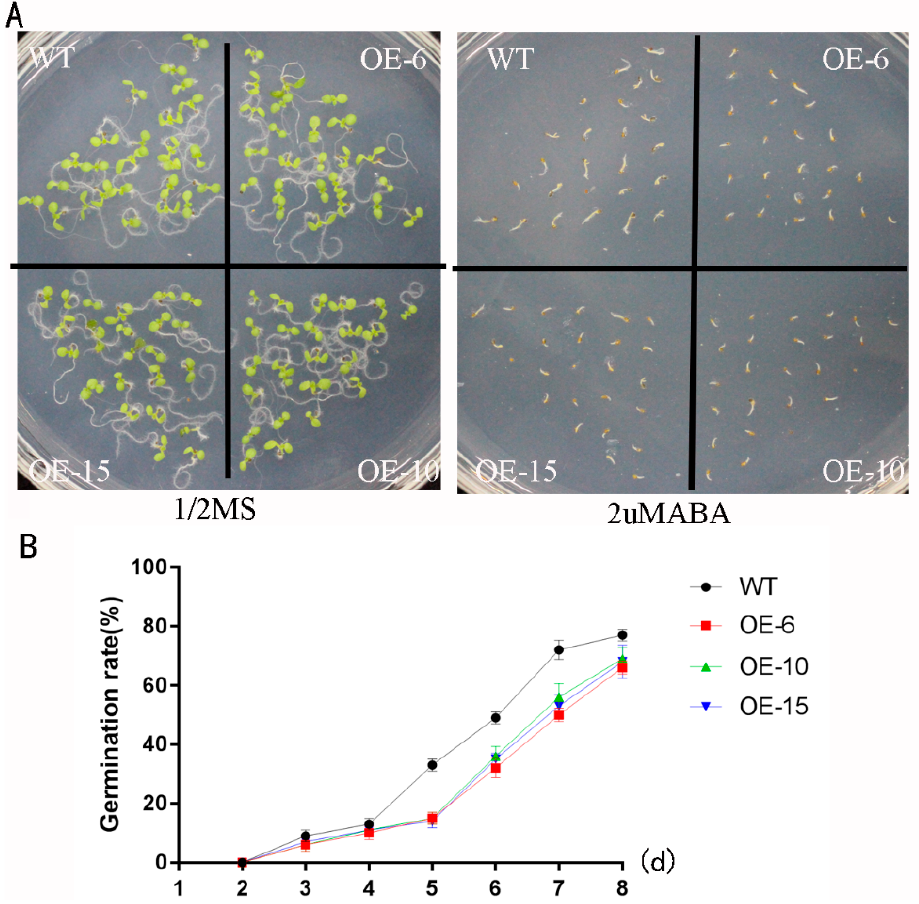
Figure 7. Phenotypes of wild-type and TaNBR1 -overexpressing transgenic Arabidopsis lines under treatment with abscisic acid (ABA). ( A ) Seedling growth by wild-type and TaNBR1 -overexpressing transgenic Arabidopsis lines on MS medium supplemented with or without 2 µ M of ABA after incubation for 8 days at 4 ◦ C for 3 days. ( B ) Seed germination percentage rates in wild-type and TaNBR1 -overexpressing transgenic Arabidopsis lines. The data indicate the mean ± standard deviation (n = 3). Three independent replicates were conducted.